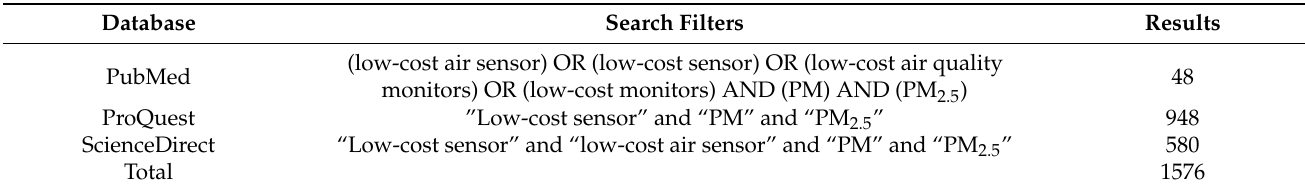
Table 1. Databases and search terms used for